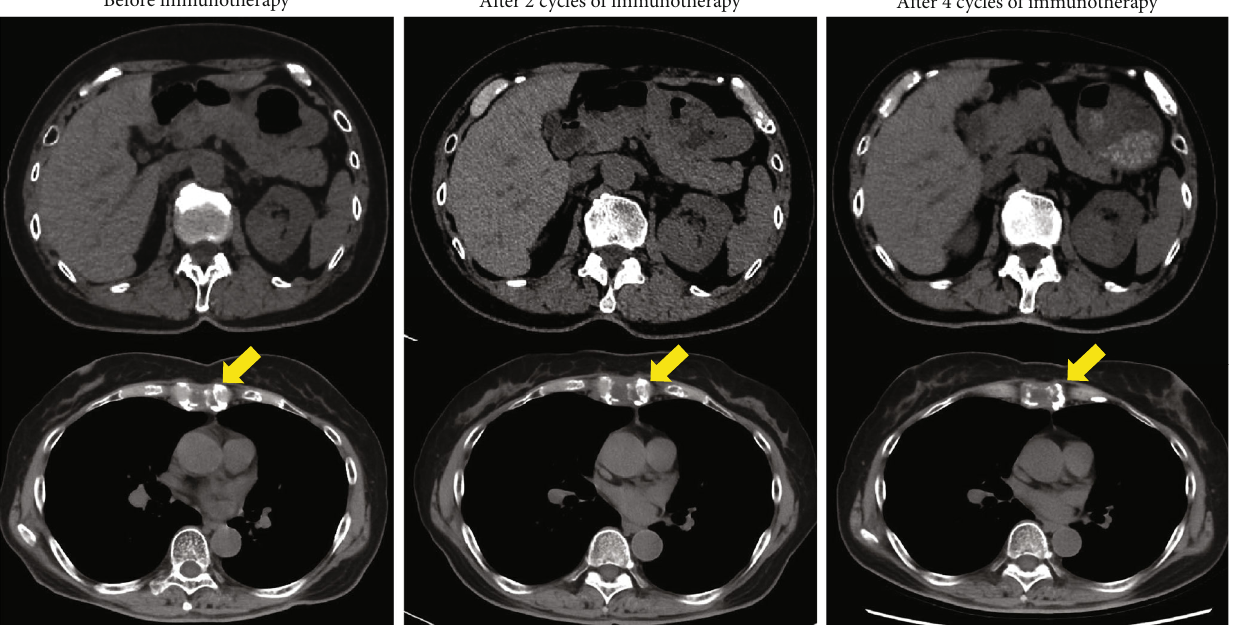
Figure 2: Computed tomography (CT) fi ndings in Case 1. Abdominal CT showed no change in the right primary renal tumor or bone metastasis after four cycles of